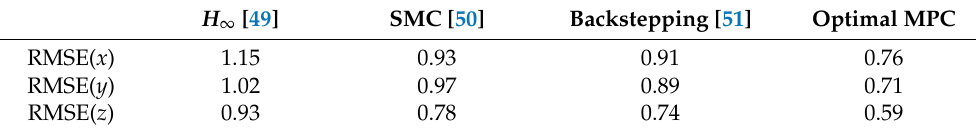
Table 2. The RMSE is compared for four different control